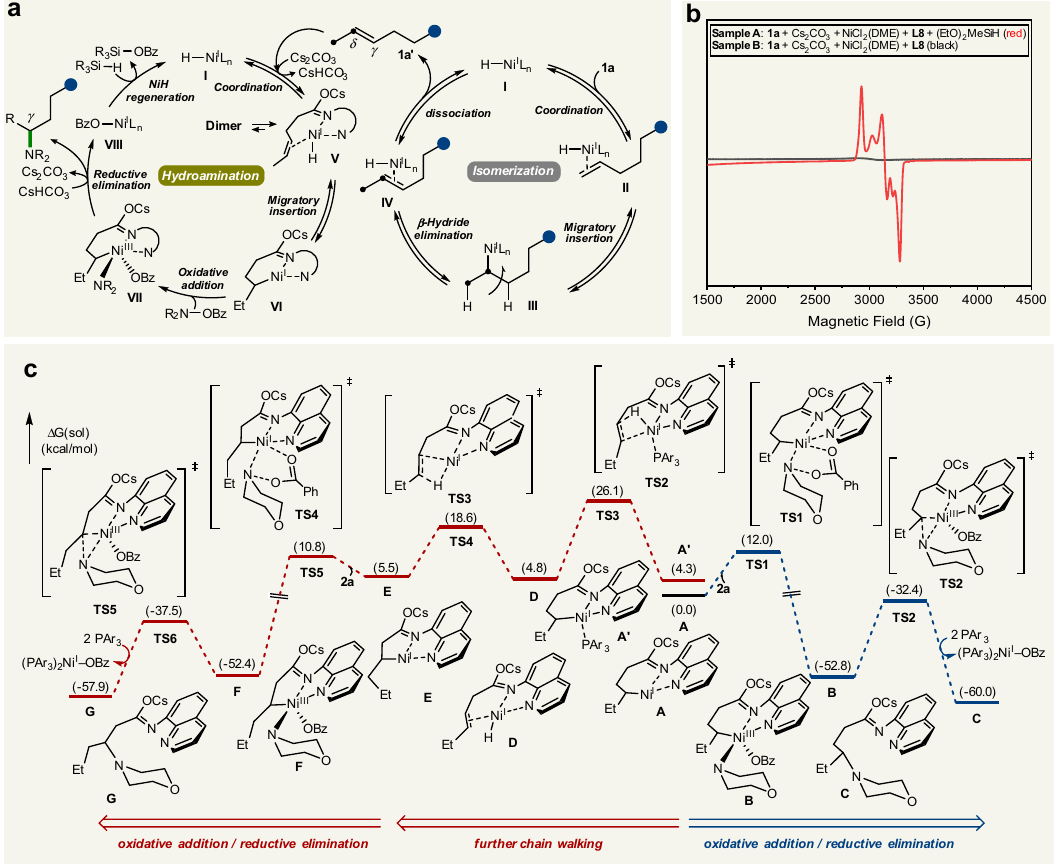
Fig. 5 Proposed reaction mechanism and DFT calculation result. a Proposed reaction mechanism. b EPR spectra of paramagnetic Ni(I) complex. c Free energy pro fi le from nickellacyle. Geometry, vibrational frequency, and solvation energy were calculated using the B3LYP-D3 and LACVP**, and B3LYP-D3 and cc-pVTZ(-f)/LACV3P** were employed to determine single-point